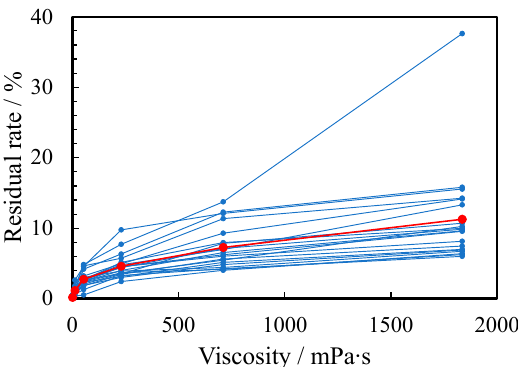
Figure 7. Relationship between residual rate and viscosity of water ( a ) and 1~5 wt% PEG500,000 aqueous solutions ( b – f ). The scores for all subjects and their arithmetic mean are plotted as small blue and large red circles, respectively.